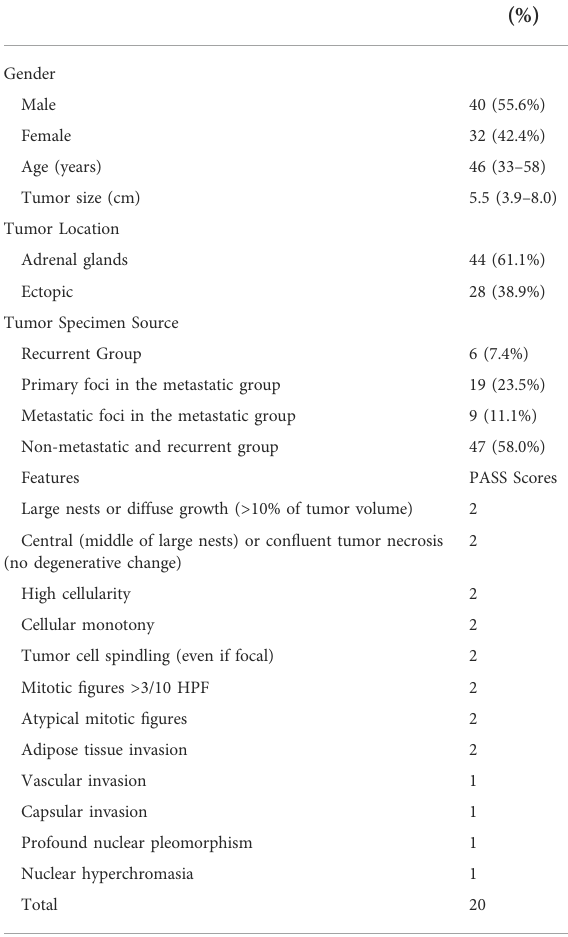
TABLE 1 Baseline demographic characteristics and Pheochromocytoma of the Adrenal Gland Scoring Scale (PASS).